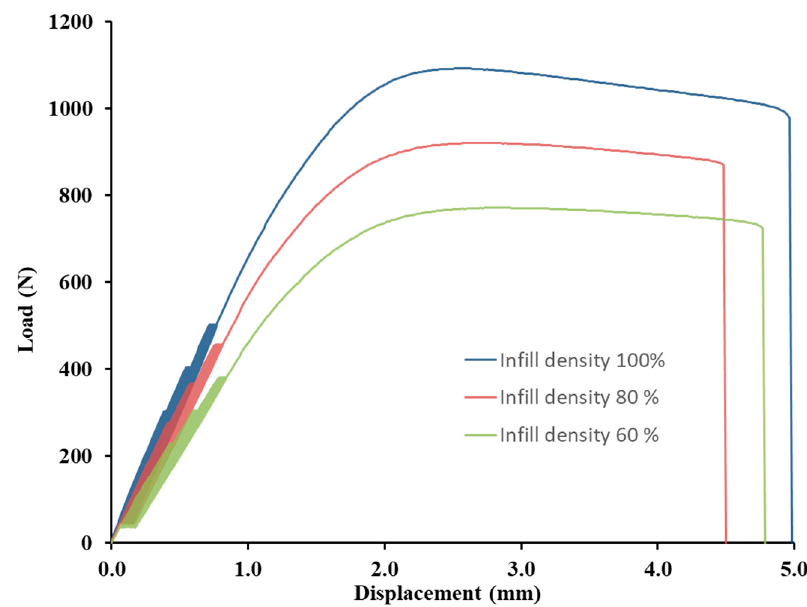
Figure 8. Influence of infill density on low-cycle fatigue using FDM 3D printing with a 0.4 mm nozzle diameter.